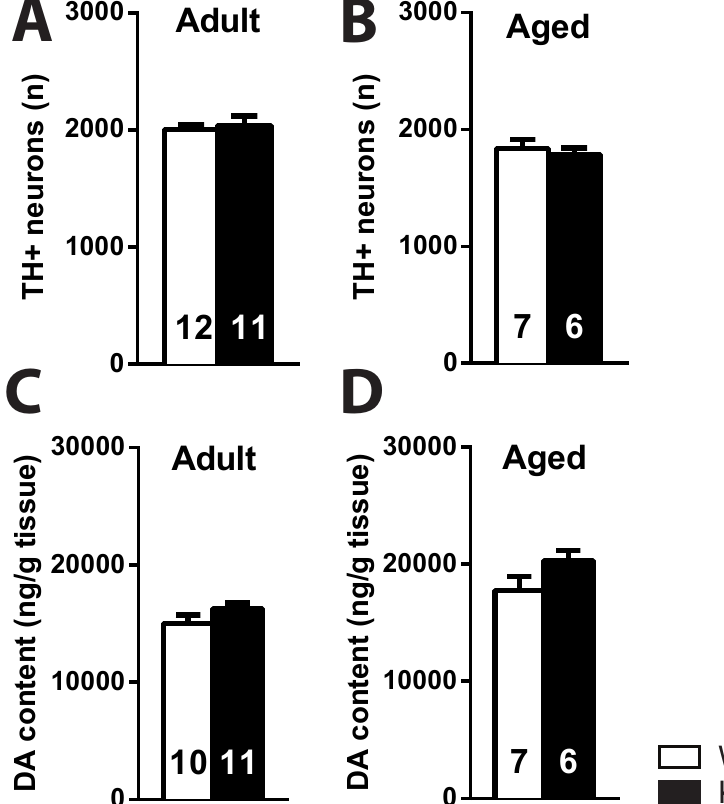
Figure 1. The nigrostriatal pathway of ghrelin receptor knockout (KO) mice is intact. No difference in the number of TH+ profiles in the substantia nigra pars compacta (SNc) (average of left and right SNc) ( A , B ) or striatal dopamine (DA) concentration (average of left and right striatum) of adult and aged ghrelin receptor wildtype (WT) and knockout (KO) mice ( C , D ). p > 0.05 ( t